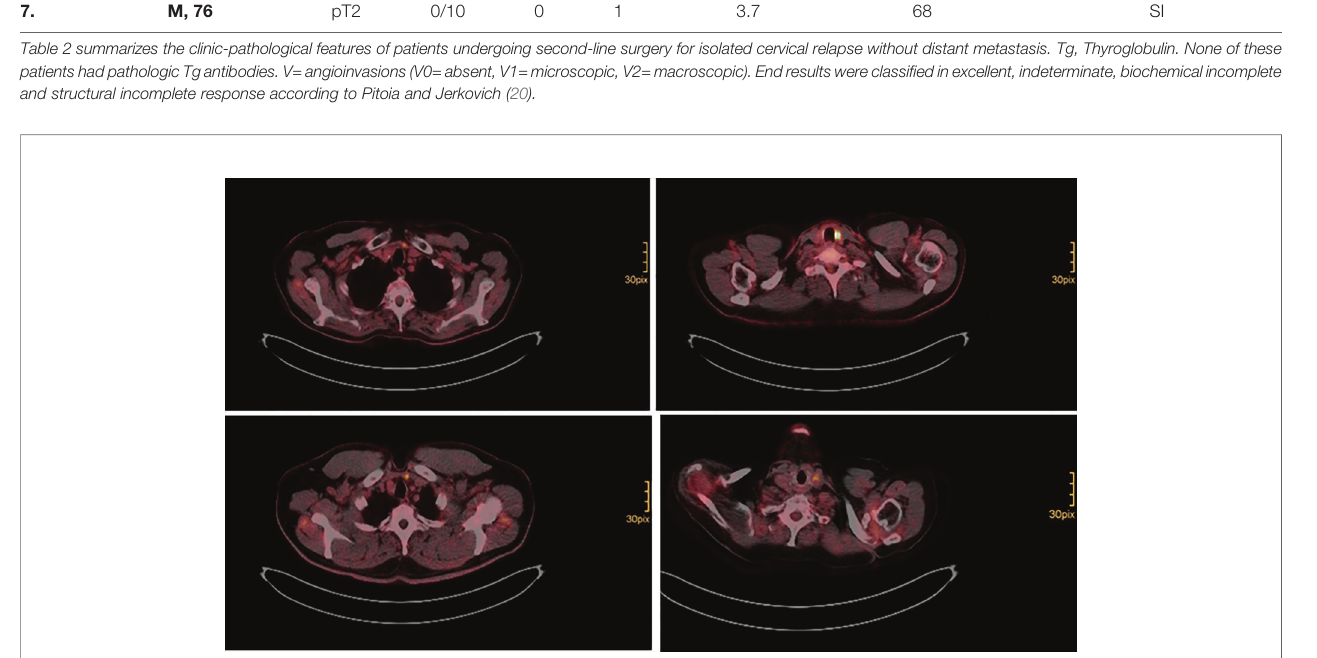
FIGURE 1 | Isolated cervical FDG positive relapse in four patients removed by